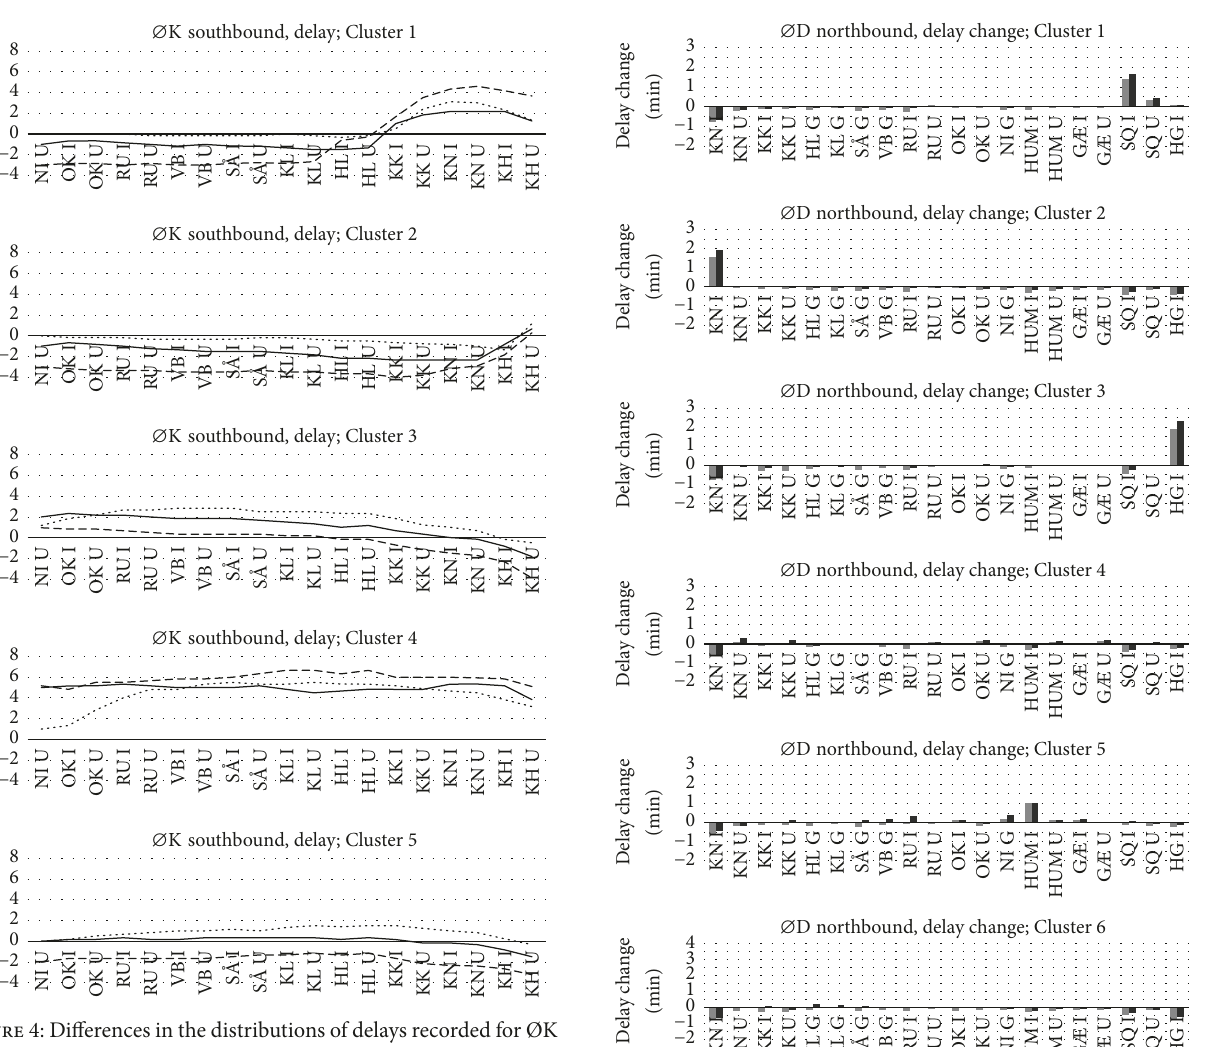
Figure 4: Differences in the distributions of delays recorded for ØK southbound trains. Each cluster’s internal distribution is compared tothepooleddistribution.15thpercentile:dotted;median:solid;and 85th percentile: dashed. Figure 5: Delay changes recorded for ØD northbound trains. Median in bright shade and average in dark shade.